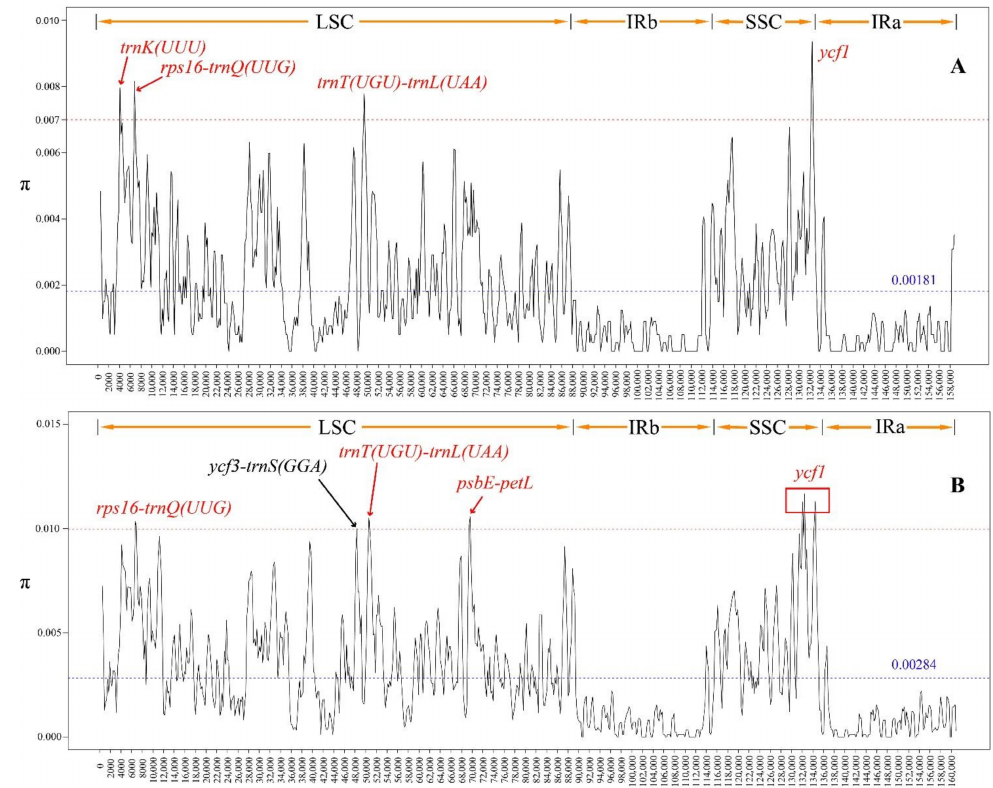
Figure 5. Gene nucleotide variability (pi) values: ( A ) gene nucleotide variability (pi) values of 13 Rosa species closely related to Rosa lucieae ; ( B ) gene nucleotide variability (pi) values of 28 Rosa species and 2 Geum